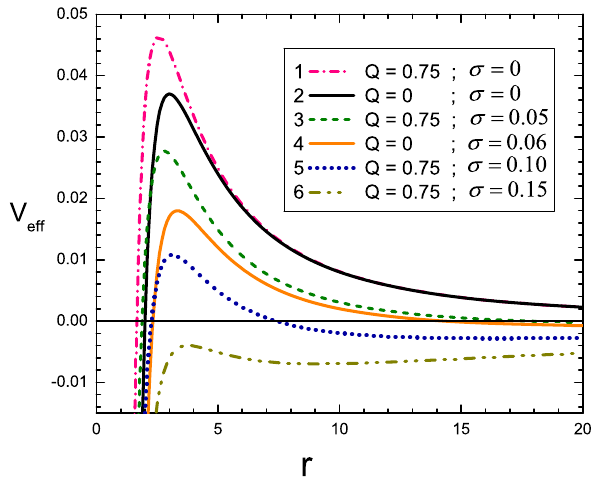
Fig. 2 Effective potential V eff is shown as a function of distance r for non-extreme case at different values of quintessence parameter σ with , the second a fixed value of the charge Q . The first upper curve for V R eff curve for V S and the fourth curve for V K are taken as a reference. The eff eff third, fifth and sixth curves are the non-extreme case of charged Kiselev black hole effective potential V eff